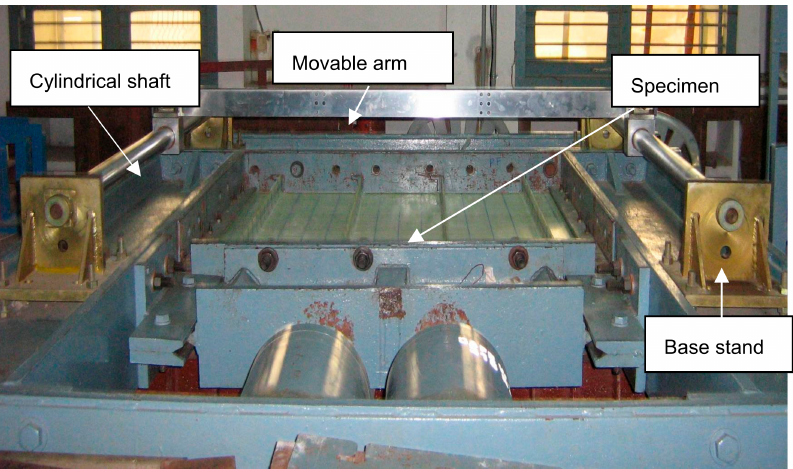
Figure 6. Initial imperfection measurement